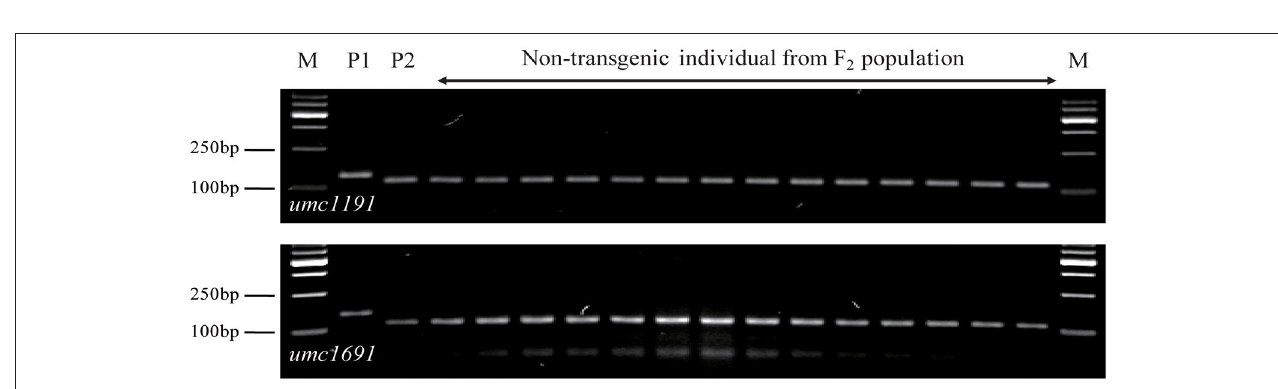
FIGURE 5 | Segregation pattern of umc1191 and umc1691 in non-transgenic individuals from the F 2 population of the SK12-5 × C7 cross; P1 for SK12-5 and P2 for C7. M, 1,000-bp DNA